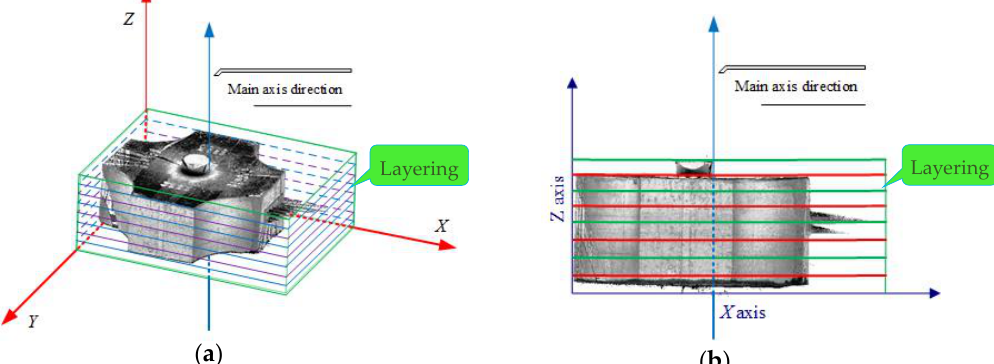
Figure 4. Point cloud layering. ( a ) Perspective view, and ( b ) Front view.